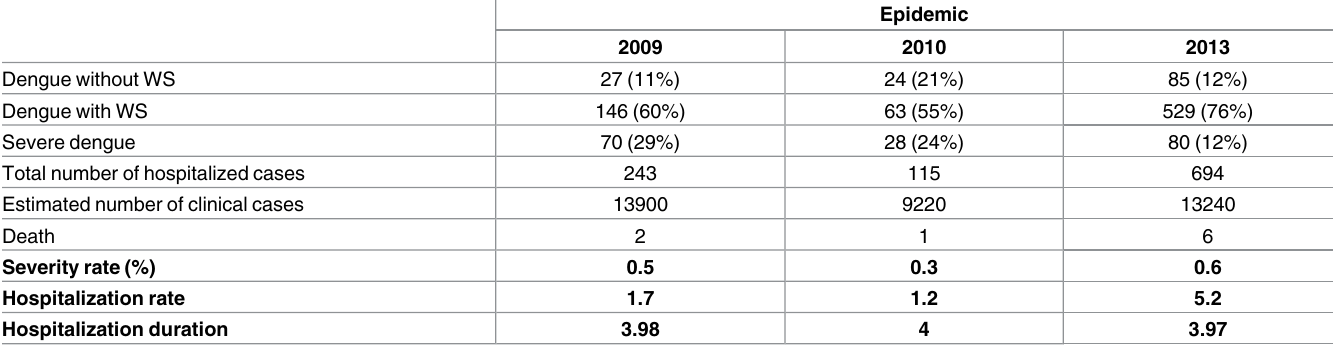
Table 2. Description of indicators related to epidemic severityin hospitalized patients, French Guiana,